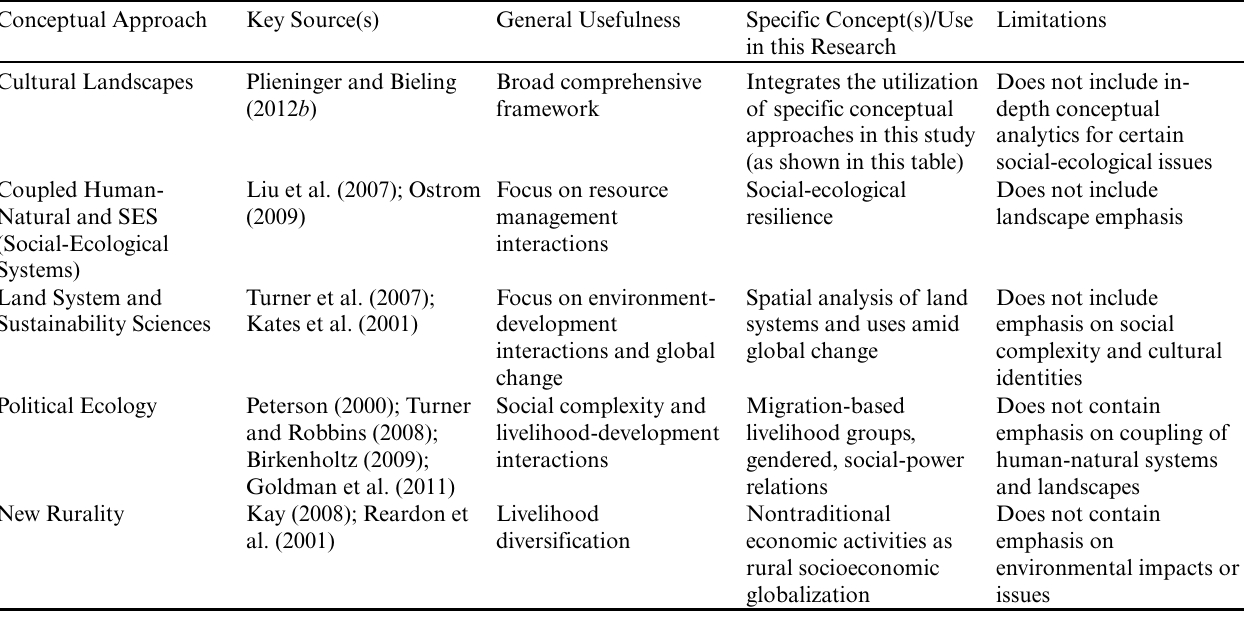
Table 1 . Framework of cultural landscapes with selective integration of